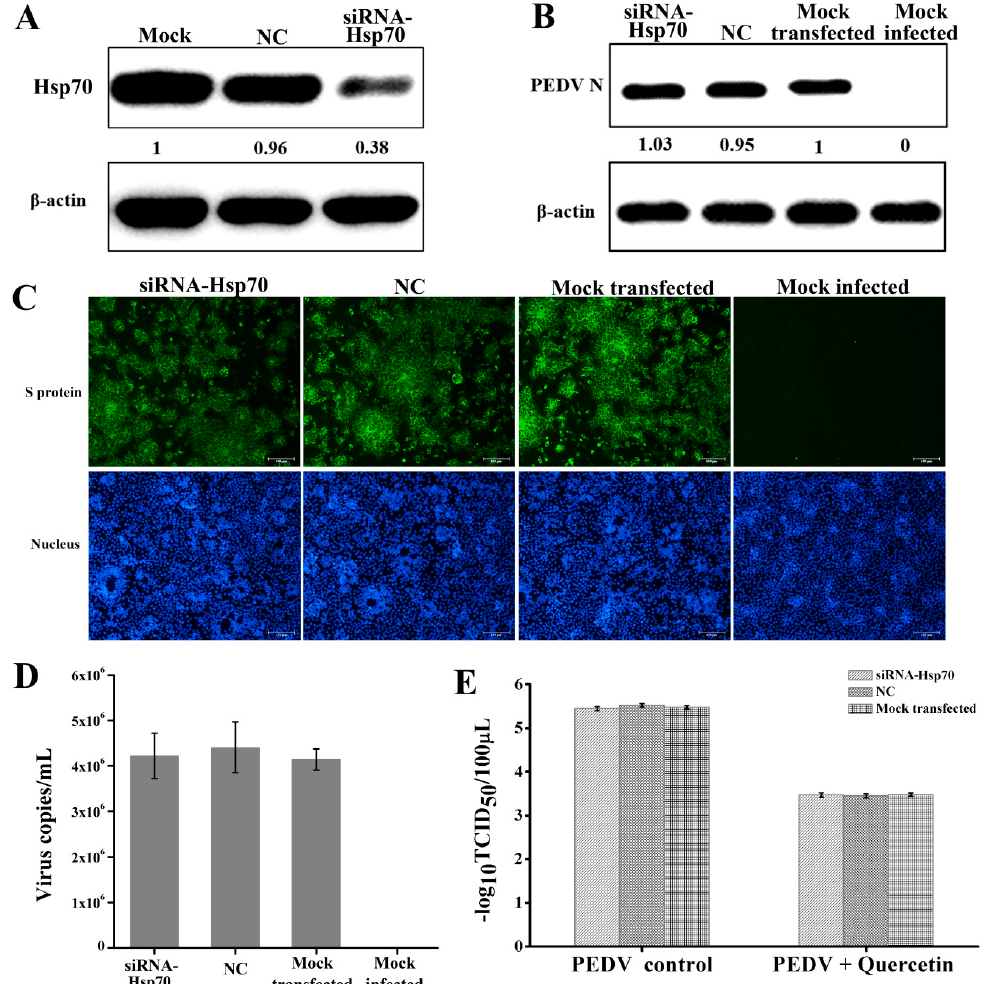
Figure 5. Analysis of the Hsp70 inhibiting activity of quercetin on PEDV replication. ( A ) CCL-81 cells transfected with siRNA against Hsp70 (siRNA-Hsp70), nonspecific control siRNA (NC), or without siRNA. Samples were collected at 48 h post transfection, and then expression of Hsp70 was analyzed by Western blot analysis. ( B – D ) CCL-81 cells transfected with siRNA against Hsp70, NC, or without siRNA for 48 h were infected with YN144 at moi of 0.001 or mock infected. Samples were collected at 24 hpi to analyze the expression of the PEDV N protein by Western blot analysis, display the numbers of PEDV-infected cells by IFA, and quantify the viral genome by quantitative real-time RT-PCR. ( E ) CCL-81 cells transfected with siRNA against Hsp70, NC, or without siRNA for 48 h and then infected with YN144 at moi of 0.001 in the presence (PEDV + quercetin) or absence (PEDV control) of 50 µ M quercetin. Samples were collected at 24 hpi, and viral titer was measured with a TCID 50 assay. Data of quantitative real-time RT-PCR and TCID 50 assay are shown as the means ± SD of at least